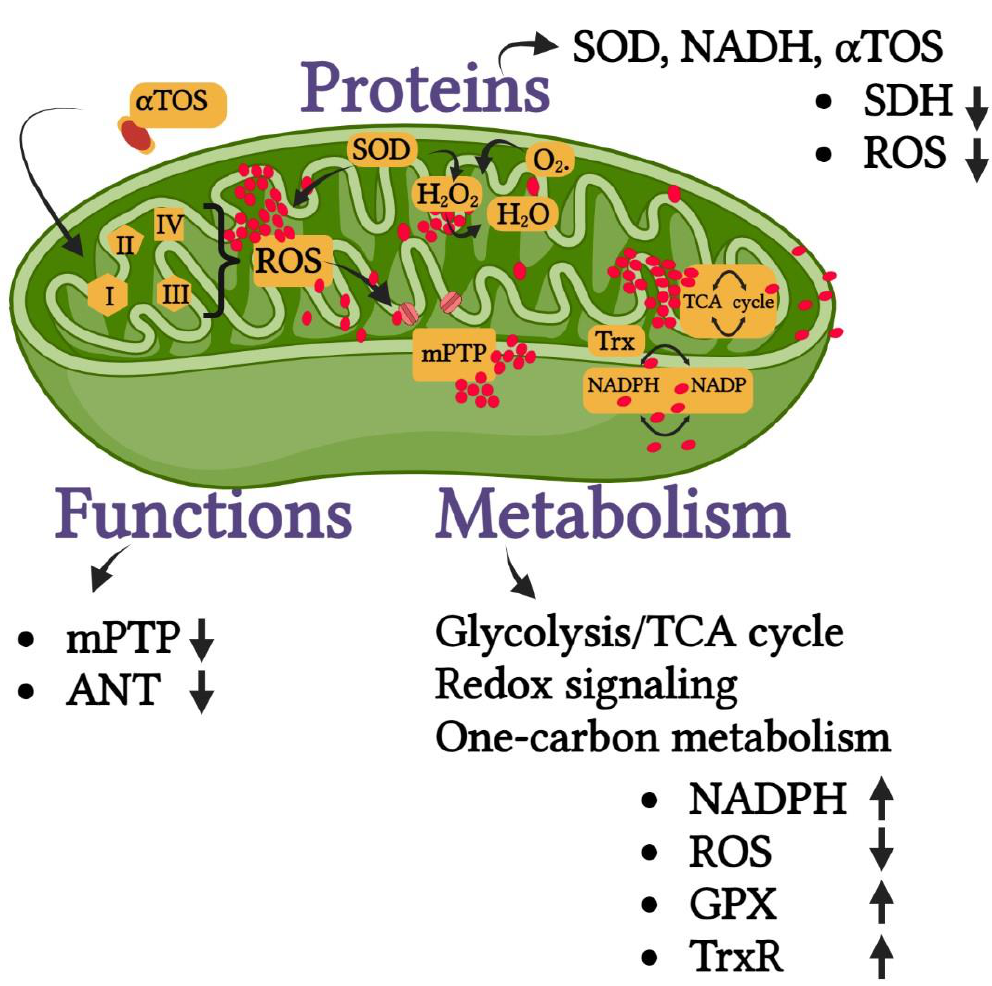
Figure 6. Possible targets to induce mitophagy in cancer. In addition to mitochondrial proteins, the function and metabolism of the mitochondria may be targeted with the metal nanoparticles resulting in mitophagy. The increase in the expression of the reaction product is indicated by the up arrow and the decrease is indicated by the down arrow. SOD — superoxide dismutase, NADH — nicotina-